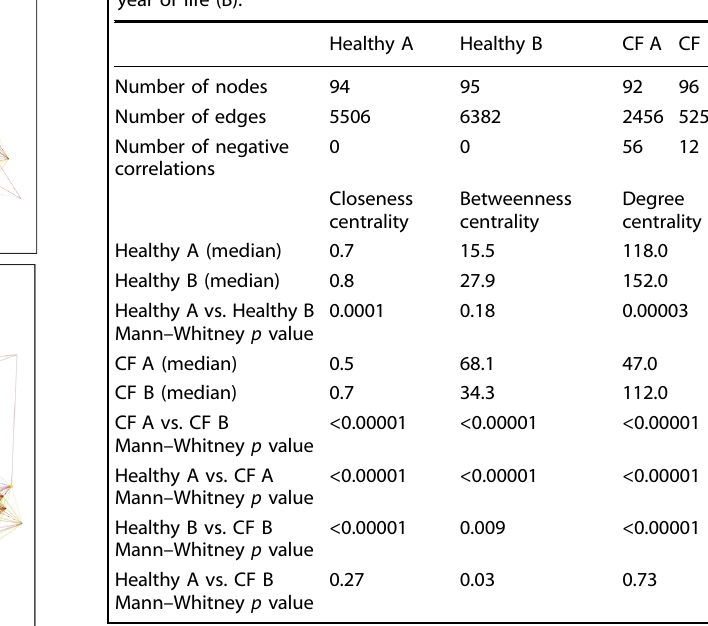
Table 3. Centrality statistics of species co-occurrence network analysis for infants in the fi rst year of life (A) and infants in the second and third year of life